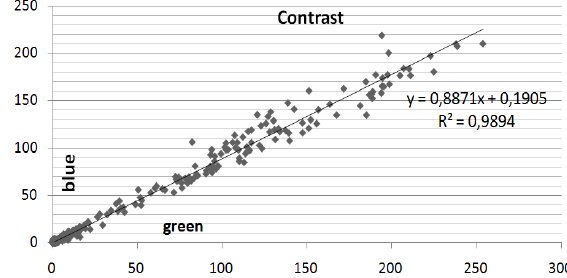
Figure 2. Regression analysis